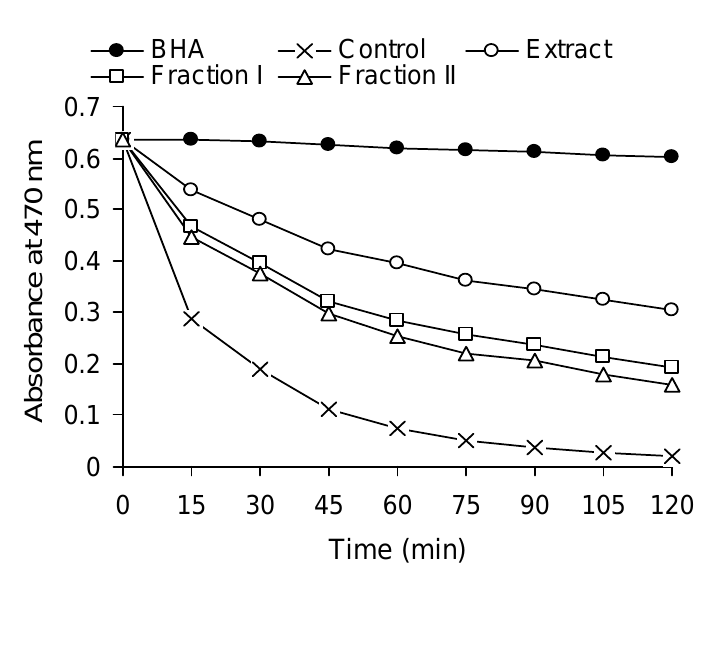
β -carotene-linoleate model system, as measured by changes in absorbance at 470